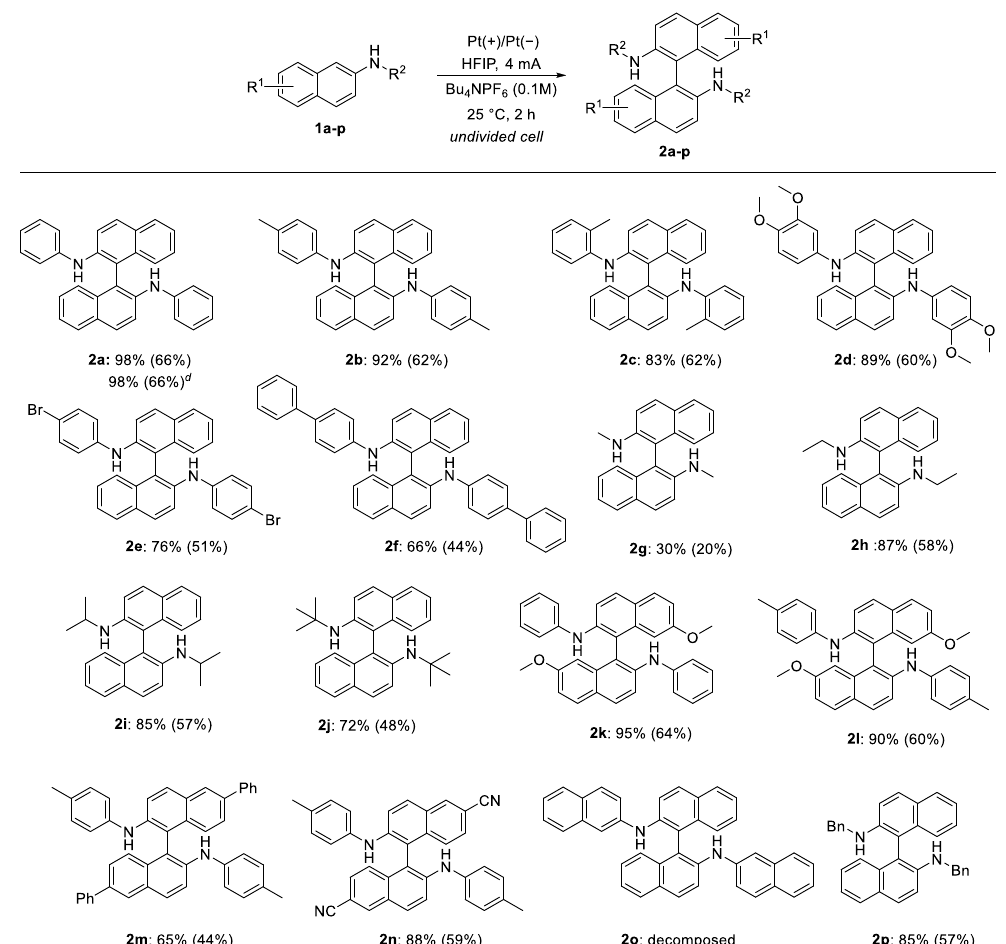
Figure 1. Substrate scope of N -naphthylamines a – c.